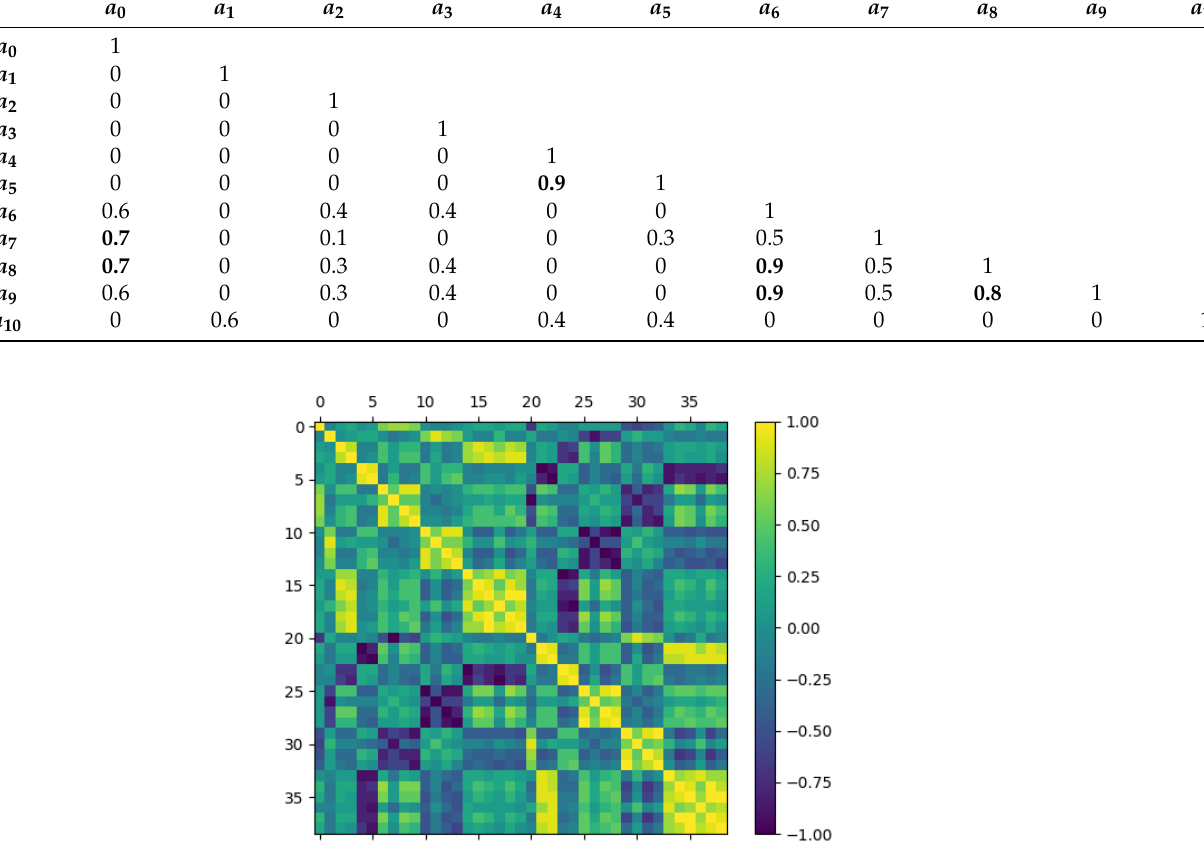
Figure 2. Visualization of correlation coefficient matrix.